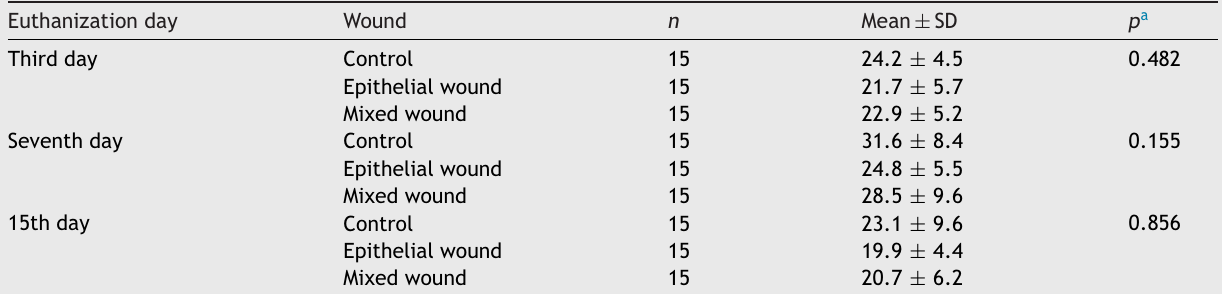
Neutrophil assessment with hematoxylin and eosin on the third, seventh, and 15th days in each wound; assessment between the groups. Euthanization